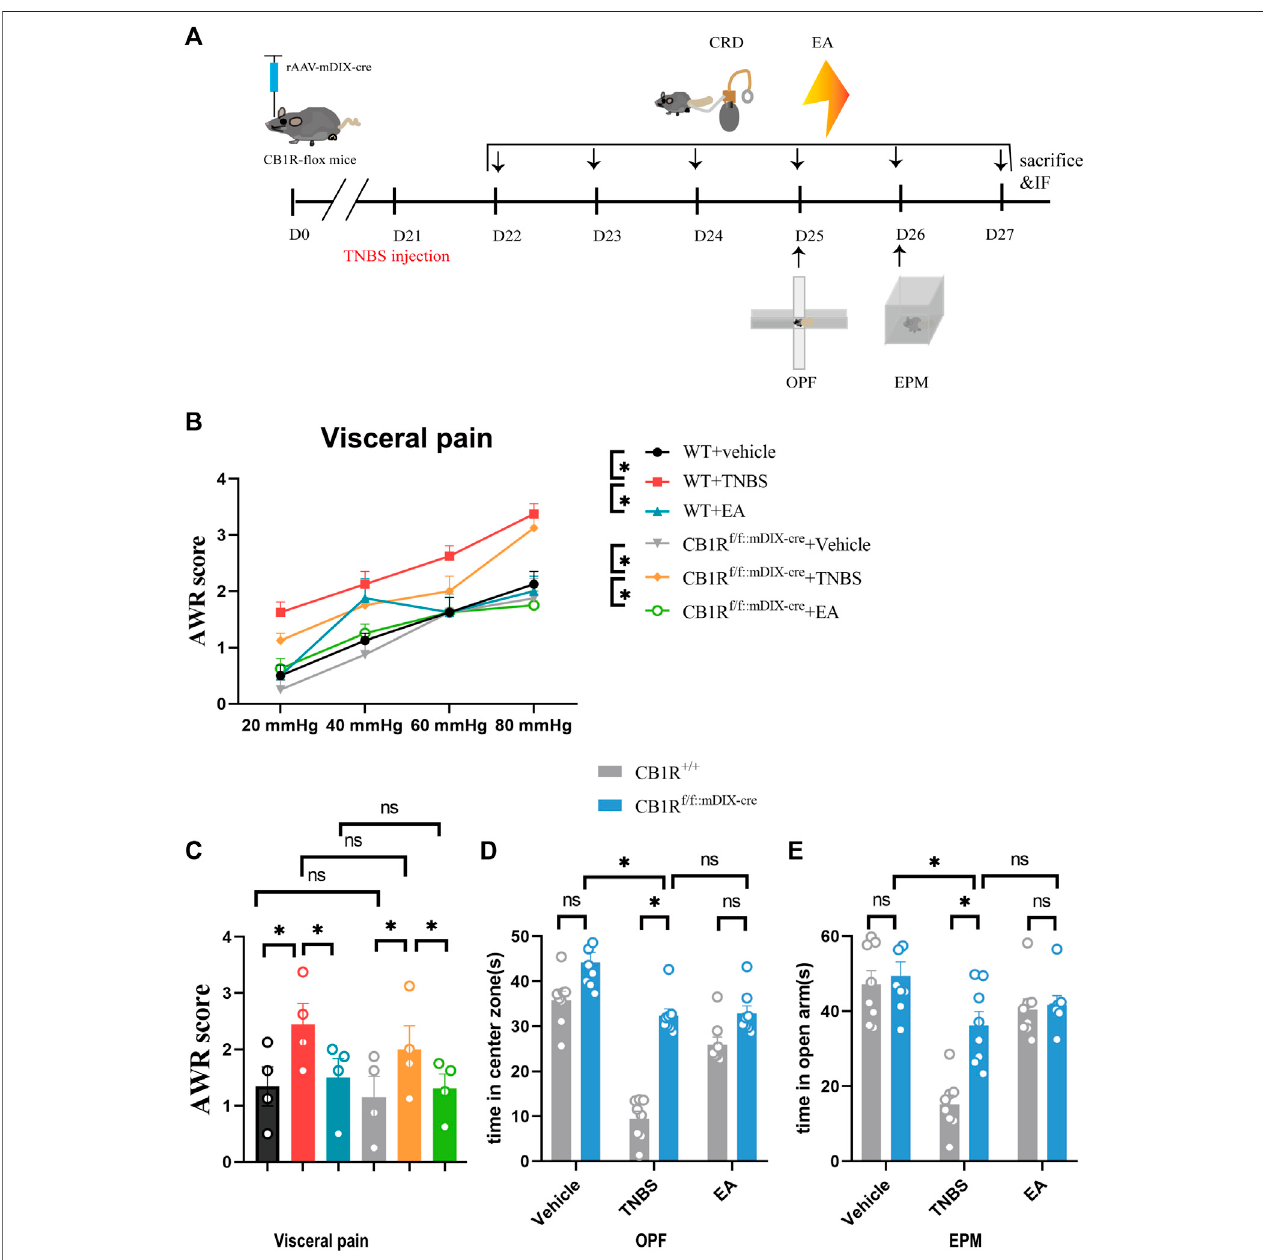
FIGURE5| Speci fi cknockoutoftheCB1RinGABAergicneuronsinthevHPCmimickedtheanxiolyticbutnotanalgesiceffectofEAonIBDmice. (A) Experimental fl owchart. (B,C) Visceral hyperalgesia was evaluated by CRD. (D) Anxiety-related behaviors were recorded as time in center zone in the OPF. (E) Anxiety-related behaviors were recorded as time in open arms in the EPM. The data are expressed as mean ± SEM ( n = 8 mice). * represents p < 0.05 between marked groups, ns represents p > 0.05 between marked groups.